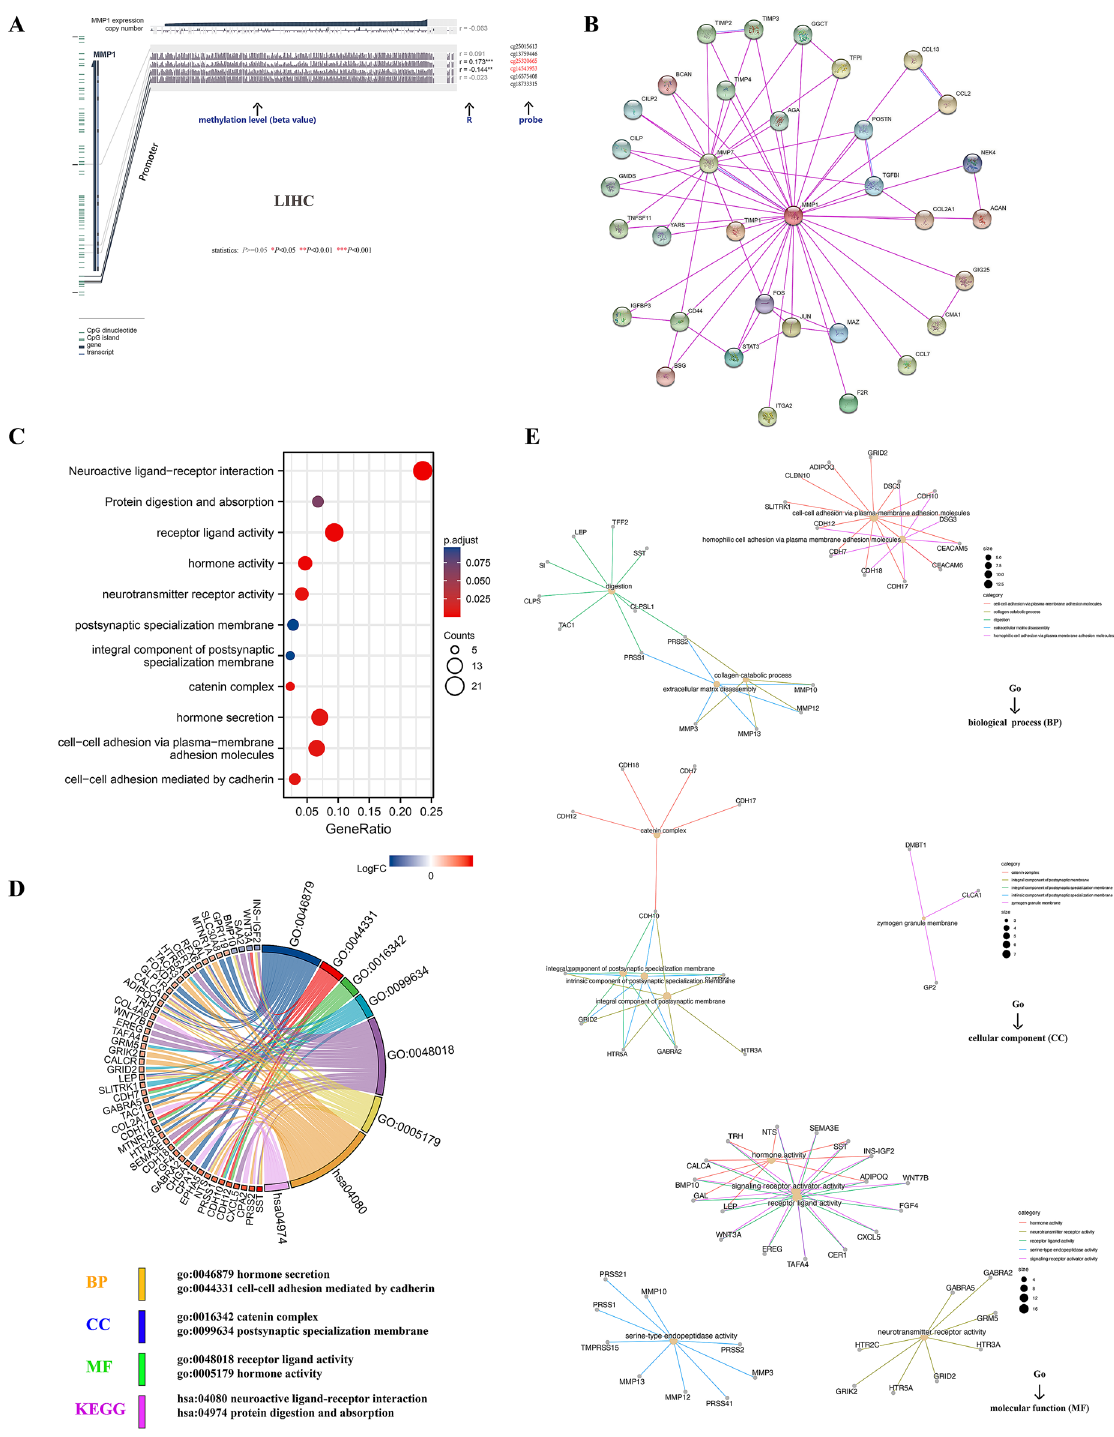
Figure 5. MMP1 DNA methylation in TCGA-LIHC and Gene enrichment analysis. ( A ) Correlation between MMP1 DNA methylation and LIHC expressed as beta value, Pearson correlation coefficients (R) and Benjamini- Hochberg-adjusted P value; ( B ) MMP1-related functional proteins association networks with experimental determination via STRING database; ( C ) MMP1-related genes KEGG pathway analysis; ( D ) MMP1-related genes Go analysis; ( E ) Centplots for molecular function (MF), cellular component (CC) and biological process (BP)